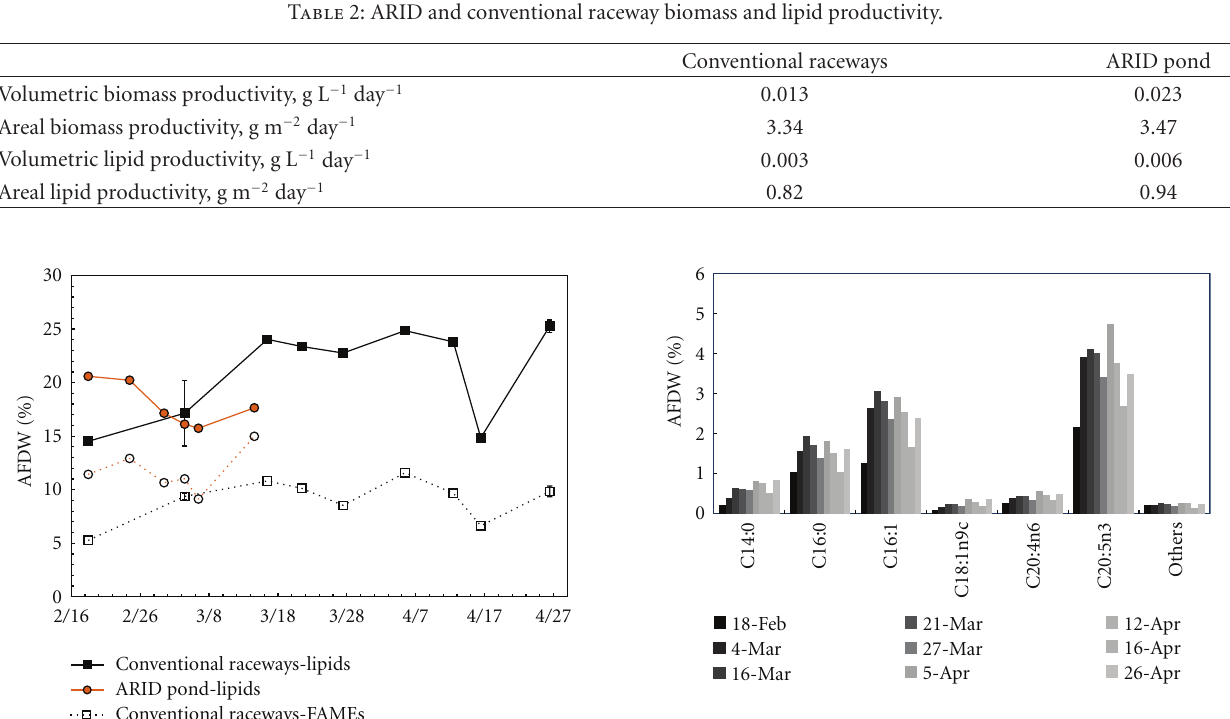
Figure 9: FAME composition of the conventional raceways, as a percentage of ash free dry weight. The Others category includes C14:1, C20:0, C18:0, C18:1, C18:2n6c, C20:1, C18:3n3, C20:2, C22:0, C22:1n9, C20:3n3, C24:1, C22:6n3, and